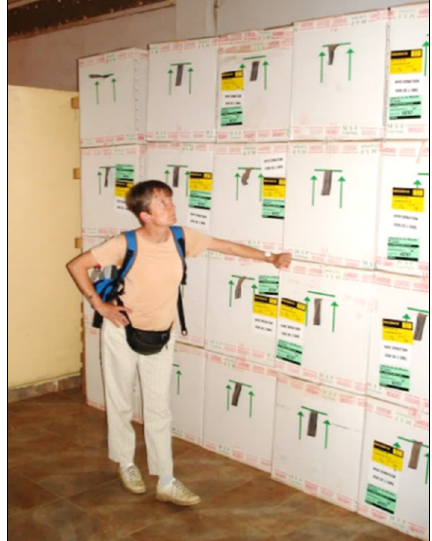
Figure 1. NECT presents a logistic challenge in the remote rural areas where HAT is prevalent. One box on the picture contains the treatment for two patients with eflornithine infusions. Later, the same boxes contained the NECT treatment (nifurtimox tablets and eflornithine infusion bags) for four patients. The picture shows Gabriele Pohlig, a key person for the NECT and DB289 trials, who sadly passed away in June 2022. Photograph by Sonja Bernhard.